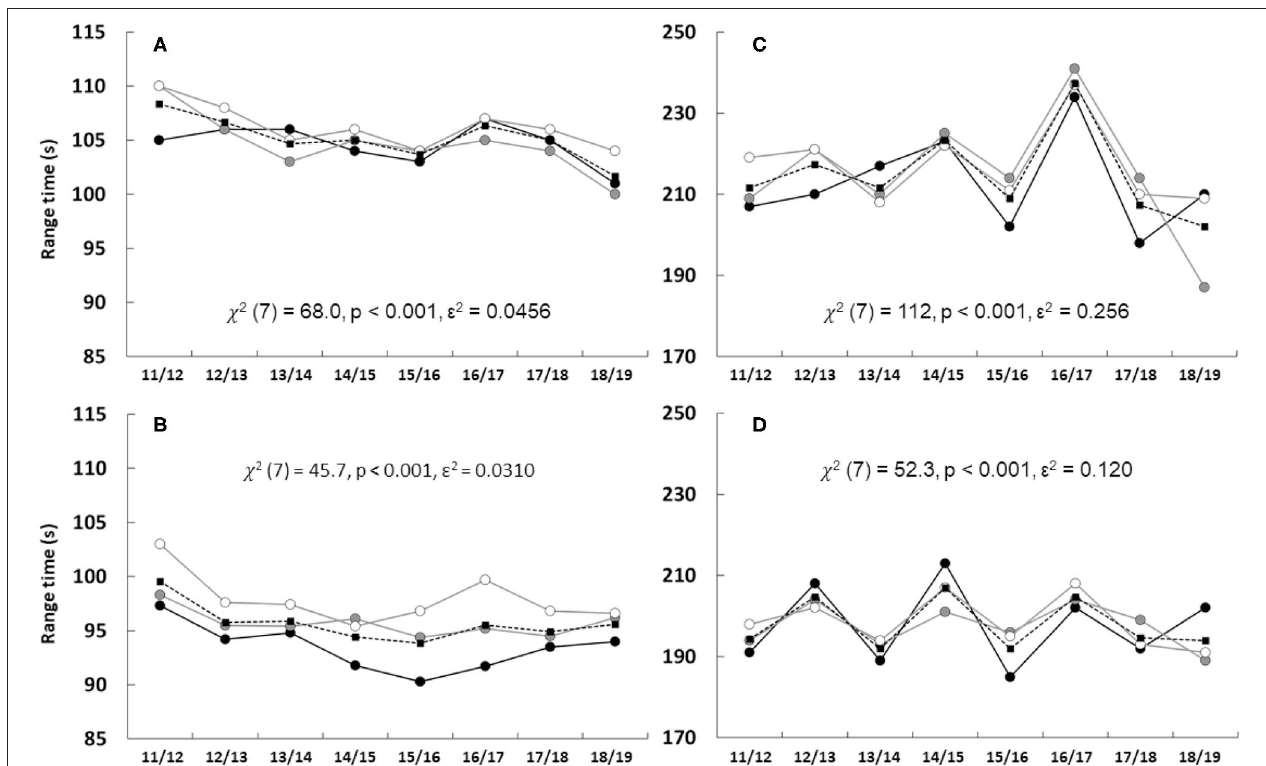
FIGURE 3 | The total range time in sprint and individual competitions for women [ (A) and (C) , respectively] and men [ (B) and (D) , respectively] including the overall (black dashed line, black squares) and groups of ranks 1–3 (black solid line, black filled circles), ranks 4–10 (gray solid line, gray filled circles) and ranks 11–20 (gray solid line, white filled circles) during seasons from 2002/2003 to 2018/2019. Each data point represents the median of all competitions during each season for each group. Sprint (A,B) and individual (C,D) include 9–10 and 3–4 competitions during each season, respectively, except season 2018/2019 having only 2 individual